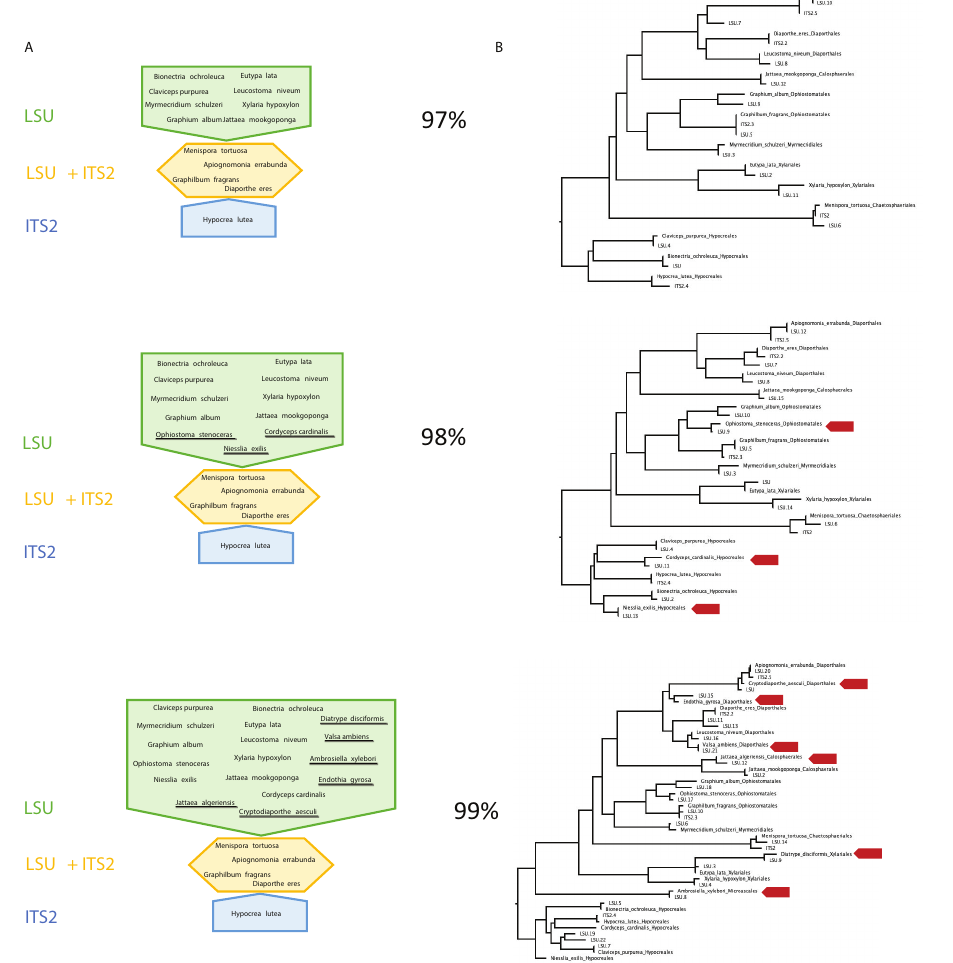
Figure 7. Closed reference clustering of OTUs and phylogenetic trees at different thresholds A results from the closed reference clustering of OTUs at each clustering threshold against composite LSU/ITS2 reference sequences. LSU matches in green, ITS2 matches in blue, linked matches (for which both an ITS2 and LSU OTU were matched to a reference sequence of the same species) in yellow. Underlined taxa indicate new matches at each clustering threshold B phylogenetic tree of LSU OTUs under increasingly stringent clustering thresholds, with arrows marking newly added taxa as threshold values are